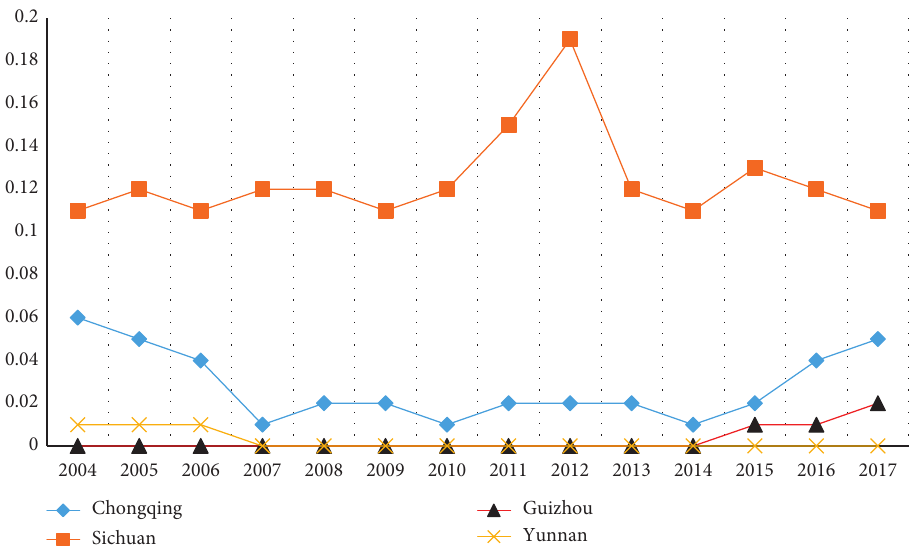
Figure 6: GFI in southwest China from